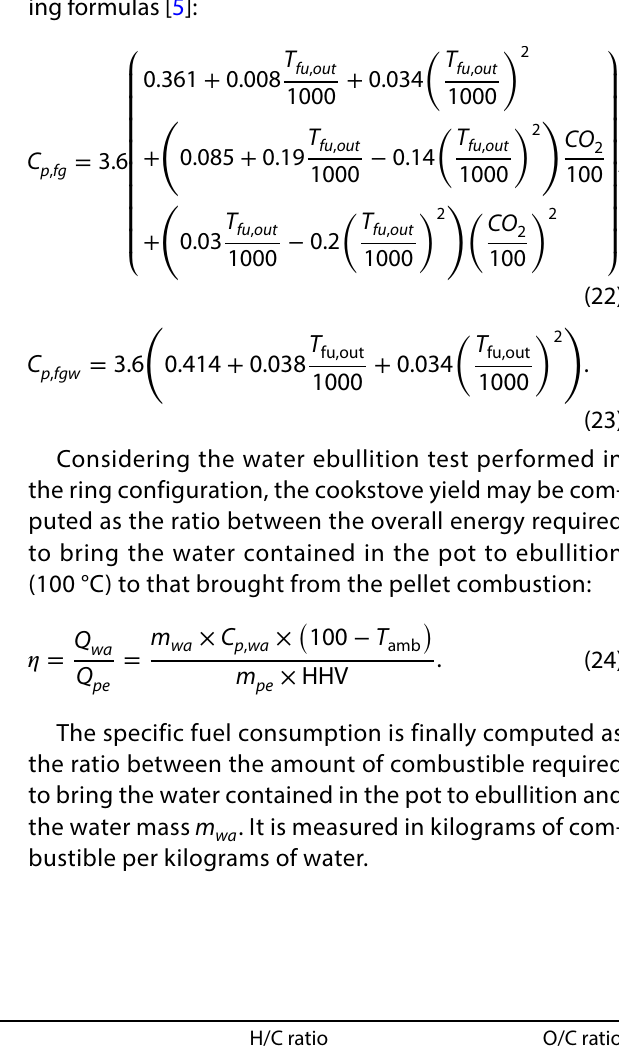
Table 1 Ultimate analysis, H/C and O/C ratios, proximate analysis, HHV and LHV, for the EN+ pellets